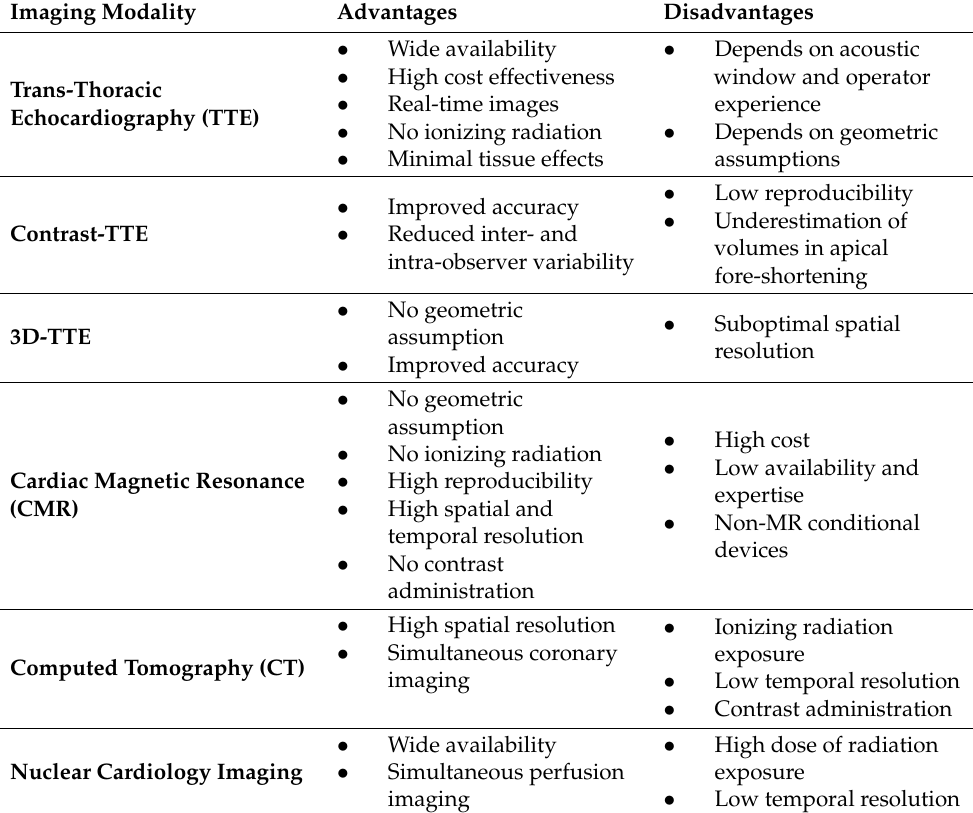
Table 1. Relative advantages and disadvantages of clinically available imaging modalities for LVEF